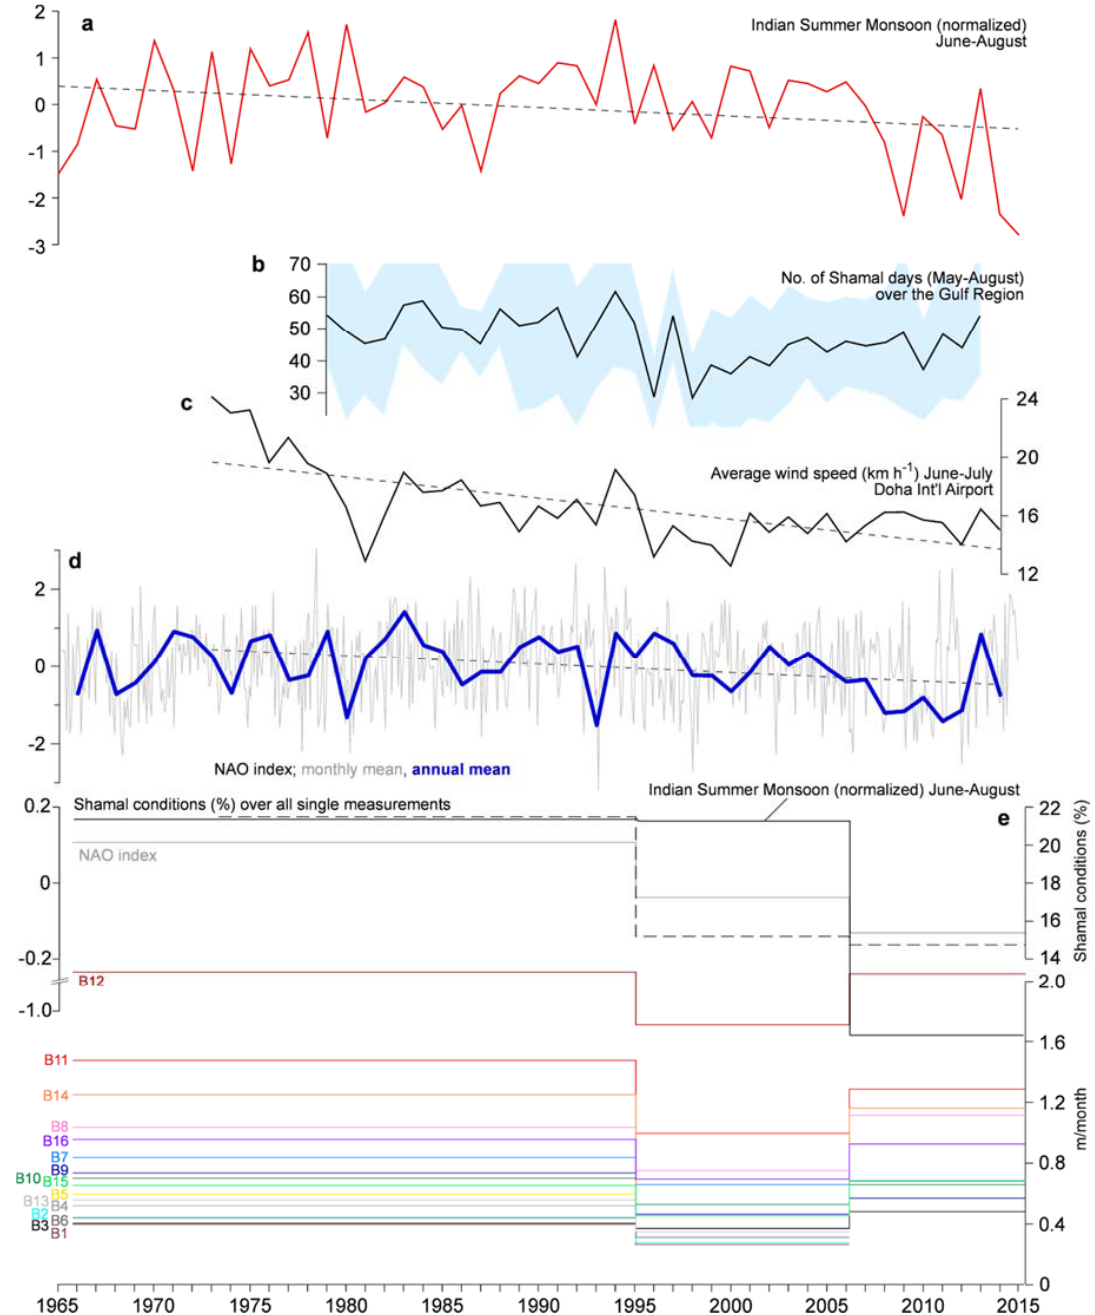
Figure 8. ( a ) Index of Indian Summer Monsoon (ISM) intensity between June and August after Wang and Fan [38] with dashed linear trend line; ( b ) Number of annual Shamal days between May and August over the entire Gulf region. The shading indicates the ±1 σ standard deviation across all stations considered [35]; ( c ) Average wind speed in the months of June and July measured at Doha International Airport [12] with dashed linear trend line; ( d ) Monthly and annual mean of the North Atlantic Oscillation (NAO) index with dashed linear trend line, representing the difference between the normalized mean winter air pressure at sea level between Lisbon, Portugal (Azores High), and Stykkisholmur, Iceland (Icelandic Low) [39]; ( e ) ISM, NAO and the percentage of Shamal conditions in Qatar averaged over the time windows of the multitemporal satellite and aerial image analysis of barchan dune migration. These data are displayed in combination with migration rates of barchan dunes B1–B16.